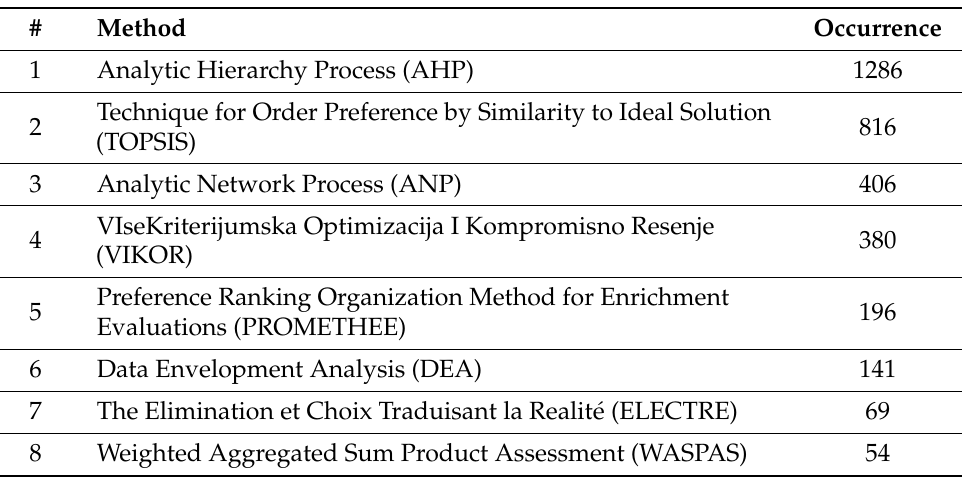
Table 1. The main MCDM methods in the